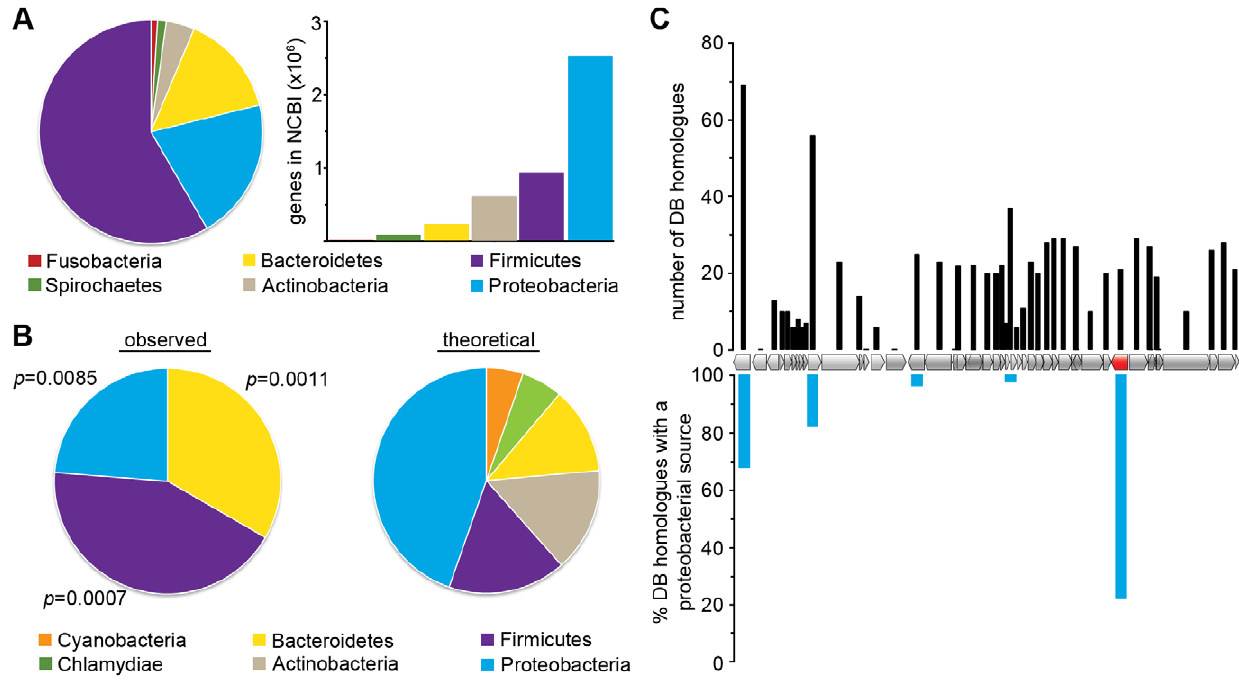
Figure 5. neaT is discordantly conserved. (A) Left: Phyletic distribution of neaT homologues among genomes retrieved from NCBI (n=317). Right: Number of gene sequences deposited in NCBI for each phylum as of November 2011. (B) Left: Pie graph showing distribution of neaT homologues among each phylum represented in the custom database (n=21 non-paralogous neaT genes). Right: Theoretical distribution of neaT homologues within phyla present in the custom database based on random chance. P values for the observed versus theoretical phyletic abundance of neaT homologues were calculated by .score analysis. (C) Upper y-axis: bar graph depicts total number of non-paralogous homologues retrieved from the custom database (DB) for each gene encoded within w b0847 (plotted along the x-axis with respect to its position within the prophage genome). The neaT open reading frame is indicated in red. Lower y-axis: bar graph showing the percent of proteobacterial homologuesfound in the homologue set for each w b0847 gene. Sequences unique to CFT073 were assigned 100% proteobacterial